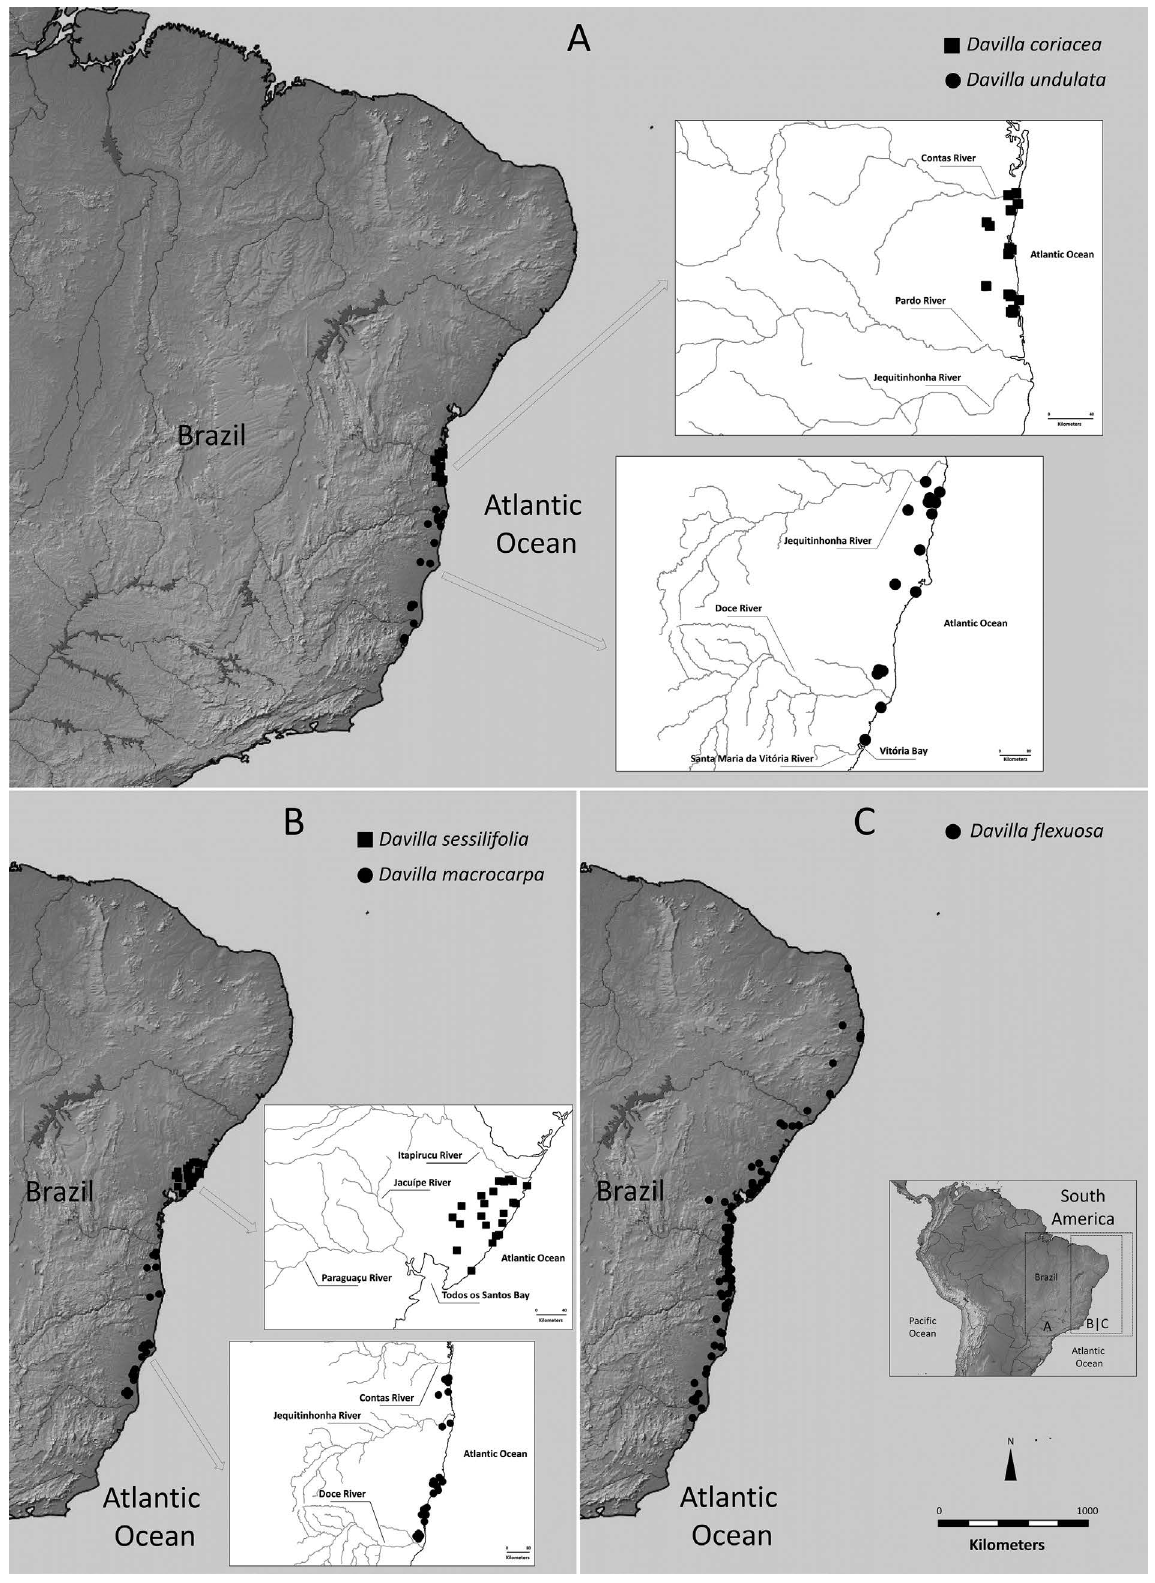
Figure 3 – The geographical distribution of of the new species and their allies in southeastern Bahia and northern Espírito Santo, Brazil: A, Davila coriacea (black squares) and Davilla undulata (black dots); B, Davilla sessilifolia (black squares) and Davilla macrocarpa (black dots); C, Davilla flexuosa (black